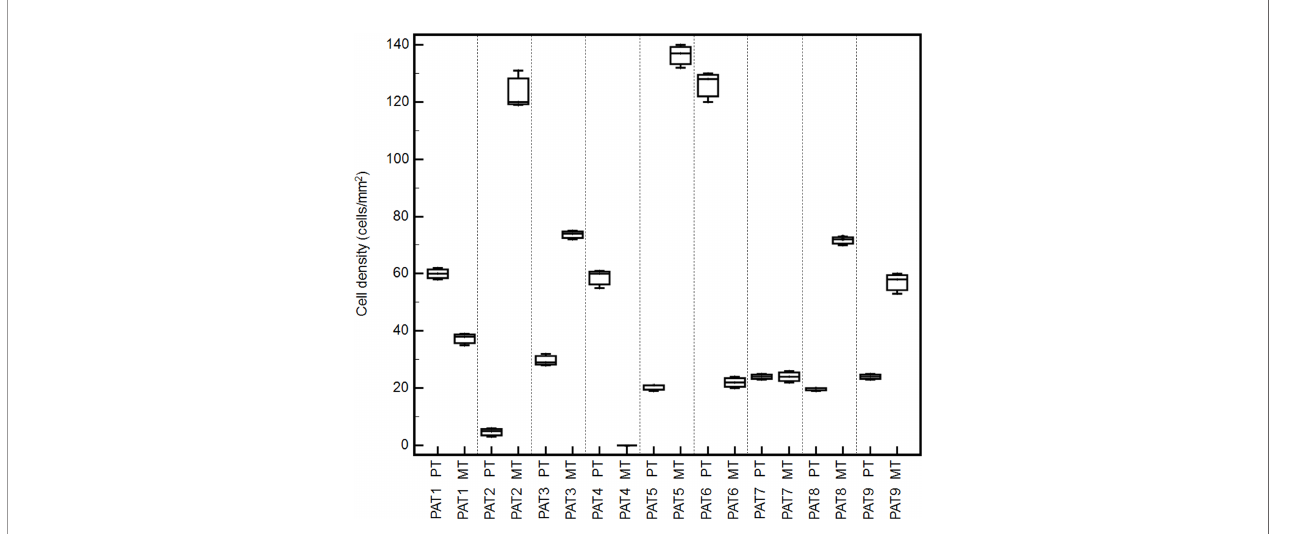
FIGURE 2 | Box-and-whisker graphs of GrzB + cell densities into tumor cores of different oligometastatic patients (PAT1-9) in matched metastatic (MT) and primary tumors (PT).